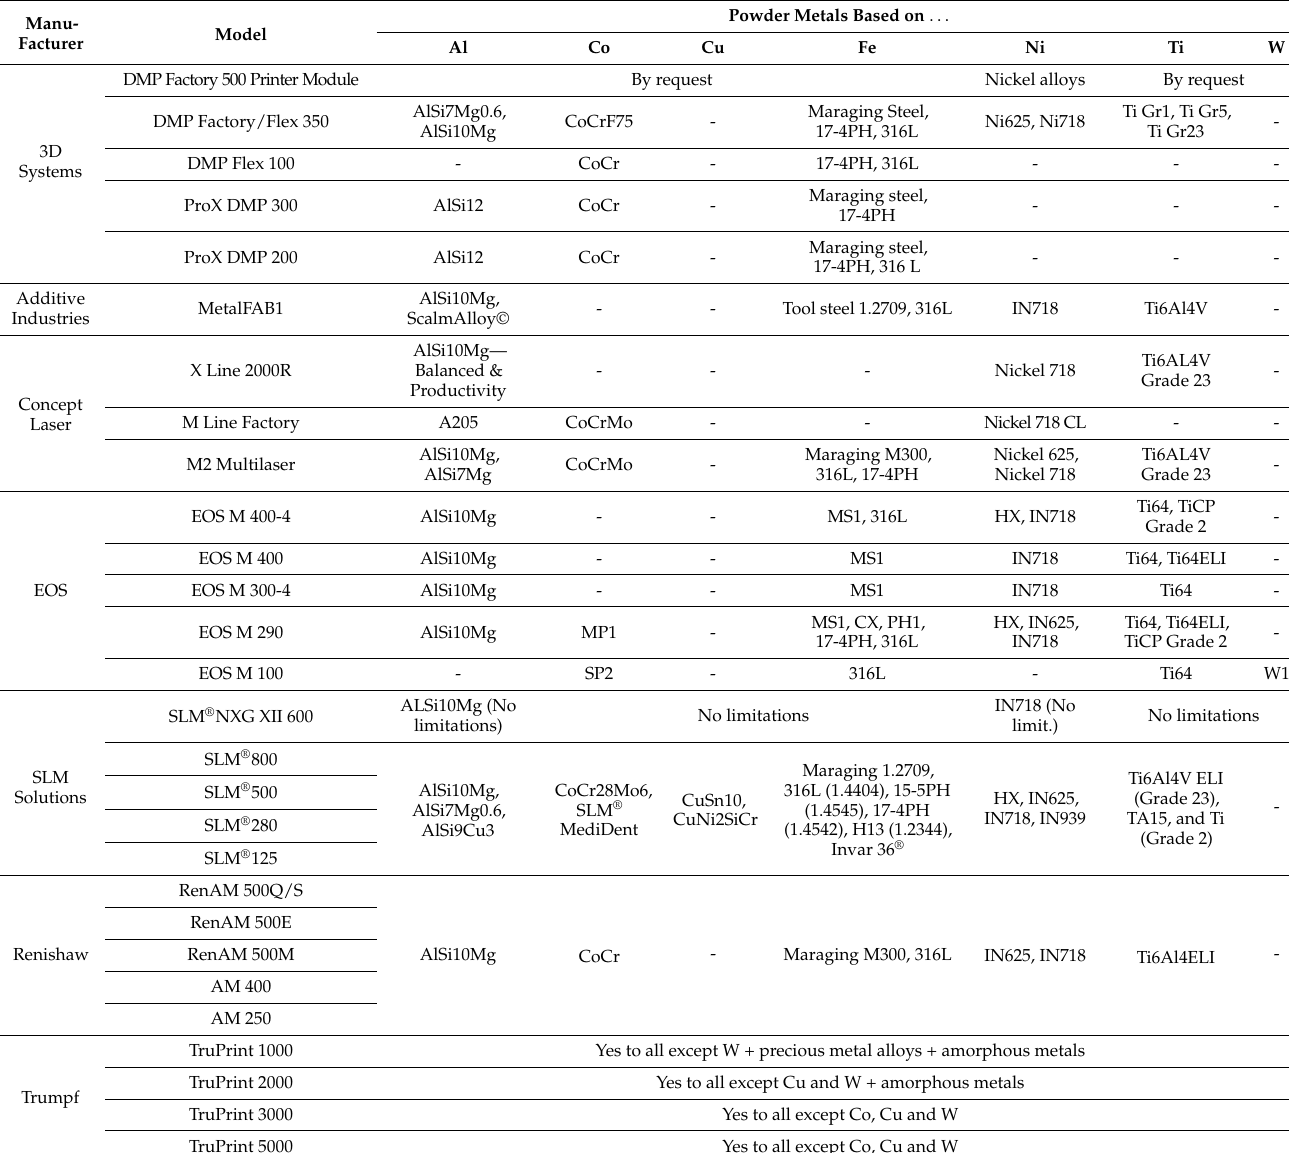
Powder Metals Based on